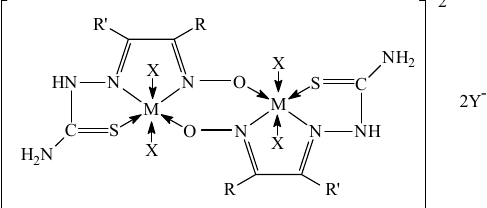
Cl complex at liquid nitrogen temperature in DMF 2 2